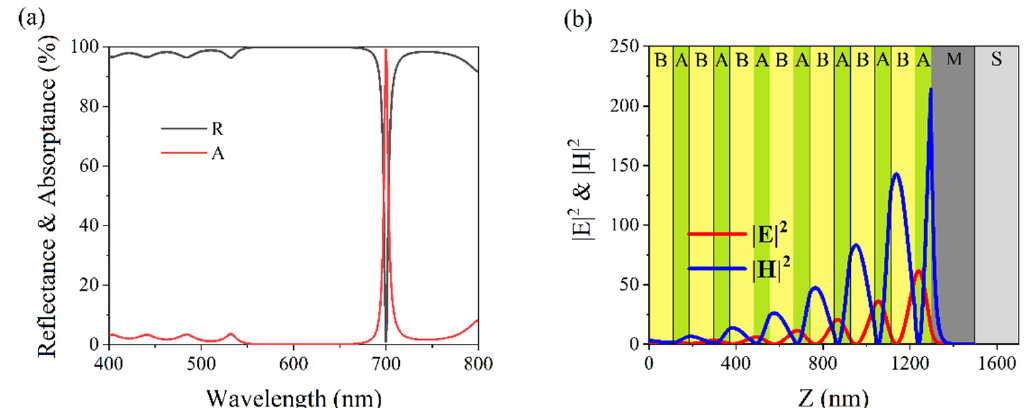
Figure 7. ( a ) Simulated reflection (solid black line) and absorption (solid red line) spectra of (BA) 7 MS. The parameters are d A = 110.7 nm, d B = 74.6 nm, d M = 200 nm. ( b ) Simulated intensities of |E| 2 (solid red line) and |H| 2 (solid blue line) in (BA) 7 MS at an absorption wavelength of 700 nm.